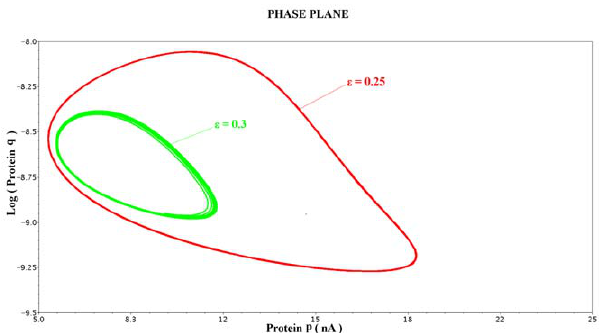
Figure 17. Phase plane analysis for the 2D gene-protein regulatory circuit with the E values set to 0.25 and 0.3. The presented results comply with a similar phase plane analysis presented in [24] for the same values of E .